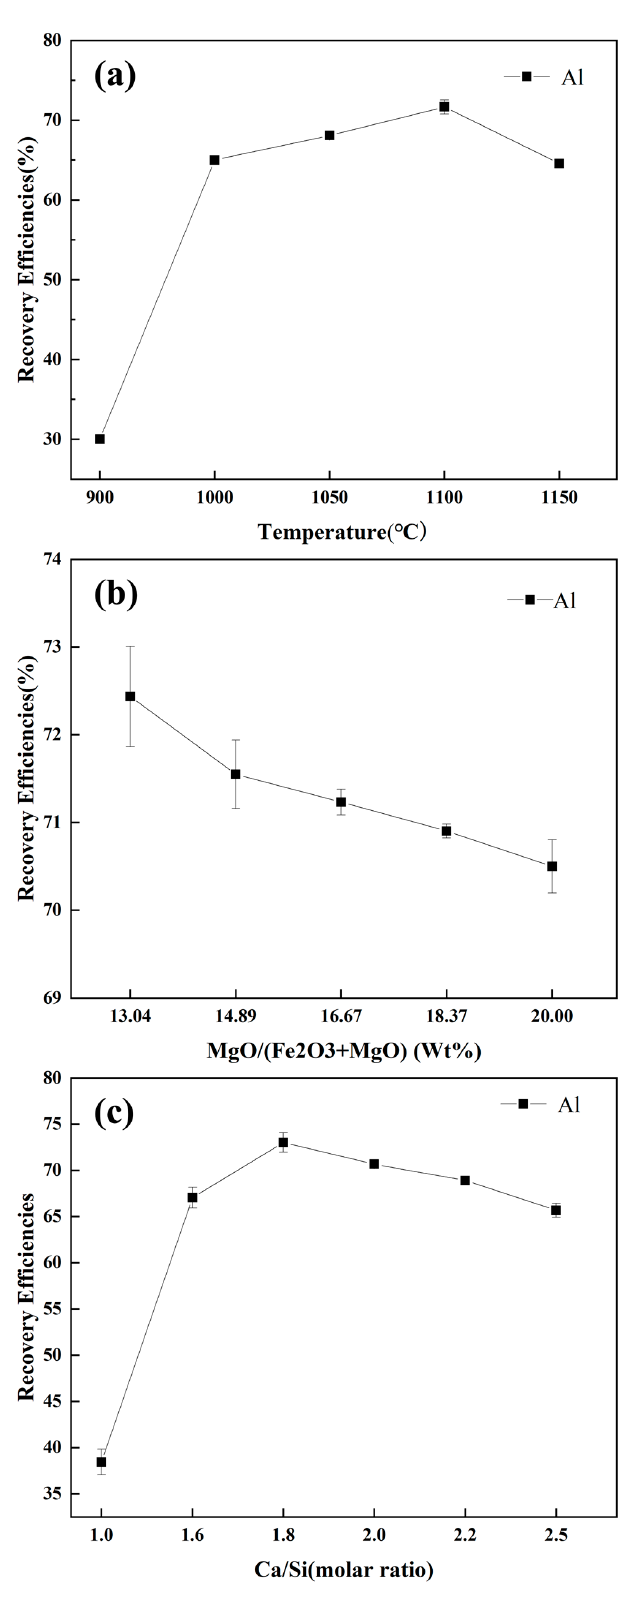
Figure 11. Recovery efficiency of alumina under different sintering conditions: calcination tempera- ture ( a ), MgO/(Fe 2 O 3 + MgO) ratio ( b ), and Ca/(Si + Ti) ratio ( c